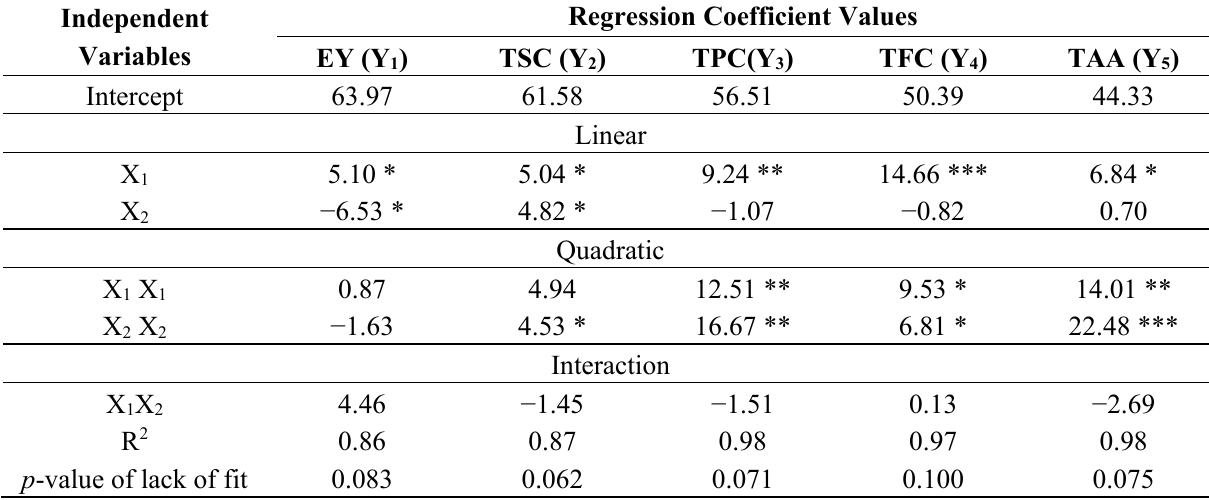
Table 4. The coded second-order regression coefficients for the encapsulation yield (EY) and the retentions of total saponin (TSC), total phenolic (TPC) and total flavonoid (TFC) content and the total antioxidant activity (TAA) for the bitter melon extract encapsulated powder obtained from the RSM CCD